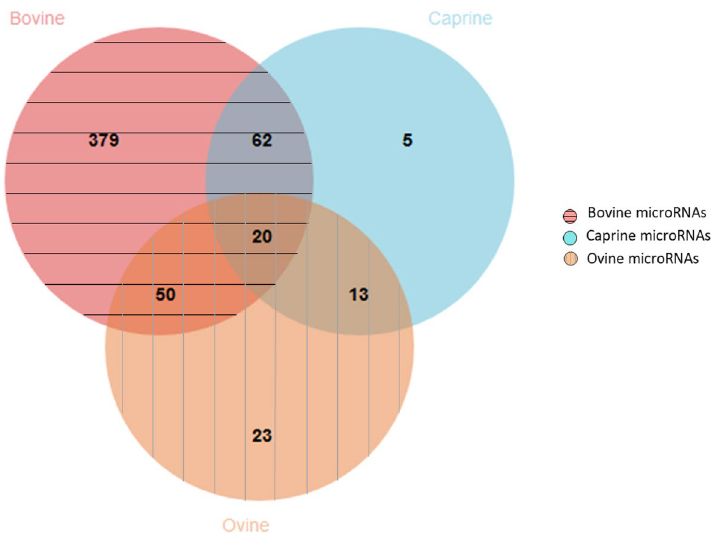
Figure 3. Number of microRNAs presenting at least one variant in bovine, caprine or ovine species and common